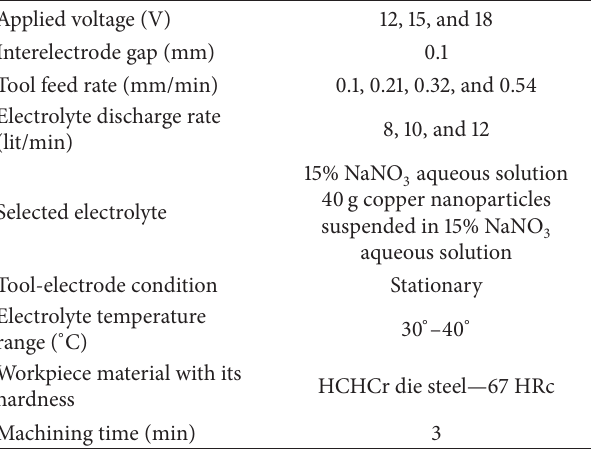
Table 2: Process